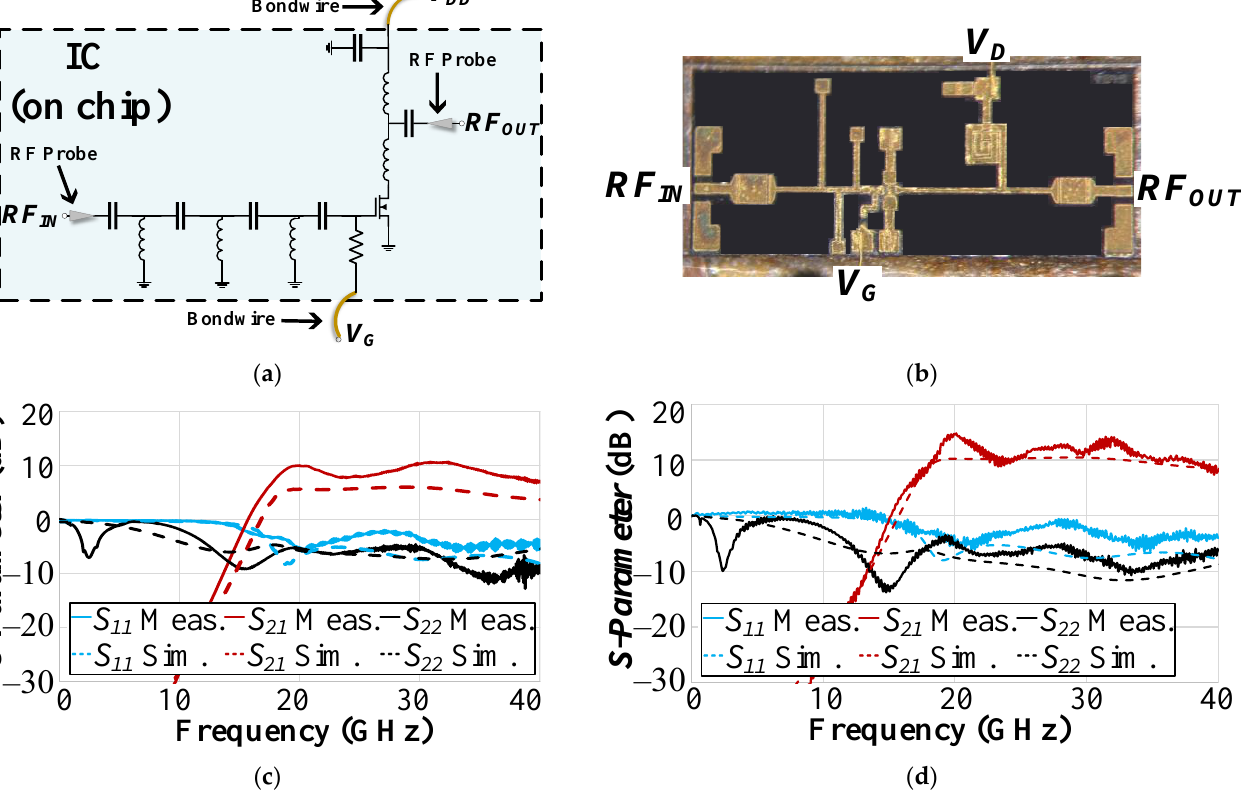
Figure 4. ( a ) Simplified schematics and the ( b ) micrograph of the broadband single-ended GaN PA (2.1 × 0.88 mm 2 with pads) and its S-Parameter EM PEX simulations vs. measurement with ( c ) V DD = 4 V; and ( d ) V DD = 6 V. The large-signal measurement results vs. post-layout EM simulations are shown in Figure 5 for V DD = 4 and 6 V at 24, 28, and 44 GHz. This PA achieves a maximum PAE/ P SAT of 34.0%/18.6 dBm at 24 GHz, 42.1%/18.6 dBm at 28 GHz, and 21.6%/17.8 dBm at 44 GHz. With a 6 V supply, there is once again good agreement between the measurement and simulation data, and the PA achieves maximum PAE/ P SAT of 28.9%/20.1 dBm at 24 GHz, 34.6%/20.3 dBm at 28 GHz, and 19.1%/19.3 dBm at 44 GHz. Figure 6 shows the measured P OUT,SAT and maximum PAE plotted across the frequency, which highlights the broadband performance of this PA as it is able to maintain greater than ~20% PAE across the entire band of 18 – 40 GHz for V DD = 4 V and greater than 14% PAE with V DD = 6 V. The peak PAE for V DD = 4 V is much higher at above 42% at 28 GHz.